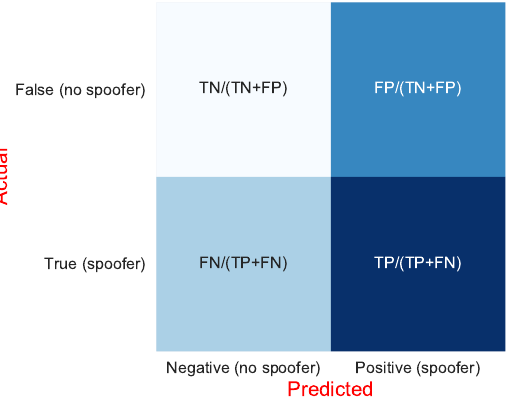
Figure 19. The illustration for normalized confusion matrix. FN is short for false negative rate, FP is short for false positive rate, TN is short for a true negative rate, TP is short for a true positive rate.